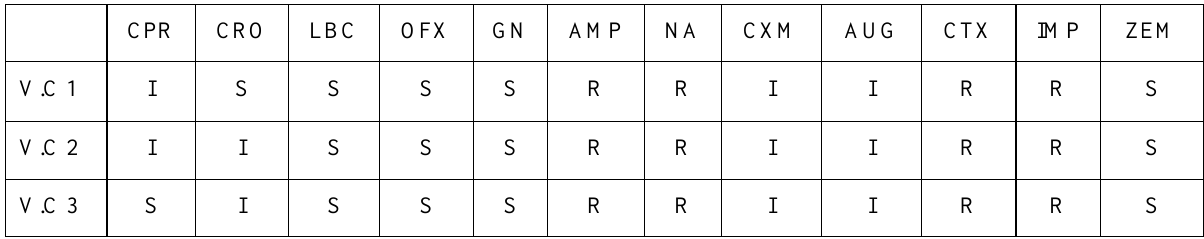
Values represent mean ±standard error. Superscripts carrying the same alphabet in the same column are not significantly different (p>0.05). Key: S-Sensitive; I-Intermediate; R-Resistance; CPR-Ciprofloxacin; CRO-Ceftriaxone-Subactam; LBC-Levofloxacin; OFX-Ofloxacin; GN- Table 5. Deduced antibiotics sensitivity pattern of multiple antibiotic resistant bacteria after plasmid curing.